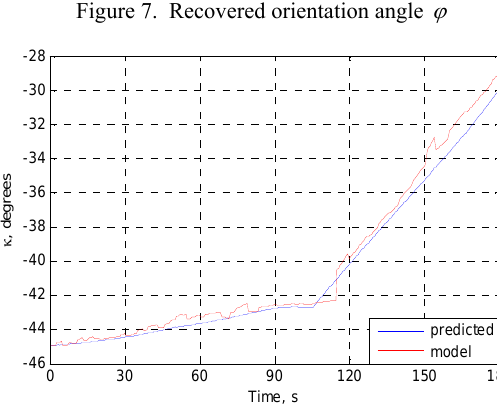
Figure 9. Frame with frare